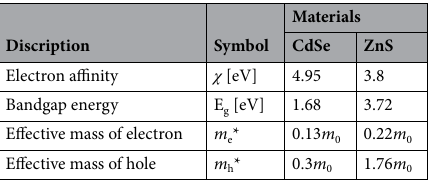
Table 1. Material parameters required in solving Schrodinger Equation 53–57